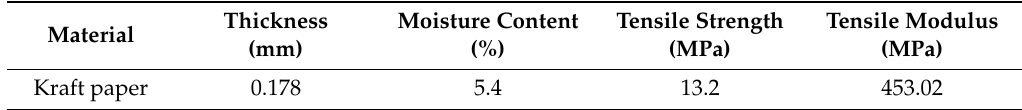
Table 2. Paper characteristics to fabricate the honeycomb core.